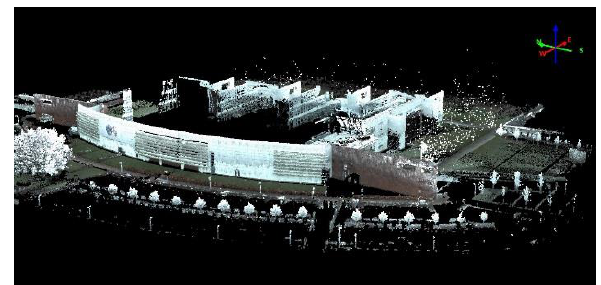
Figure 3. OS Explorer House point cloud captured using a Leica Pegasus backpack